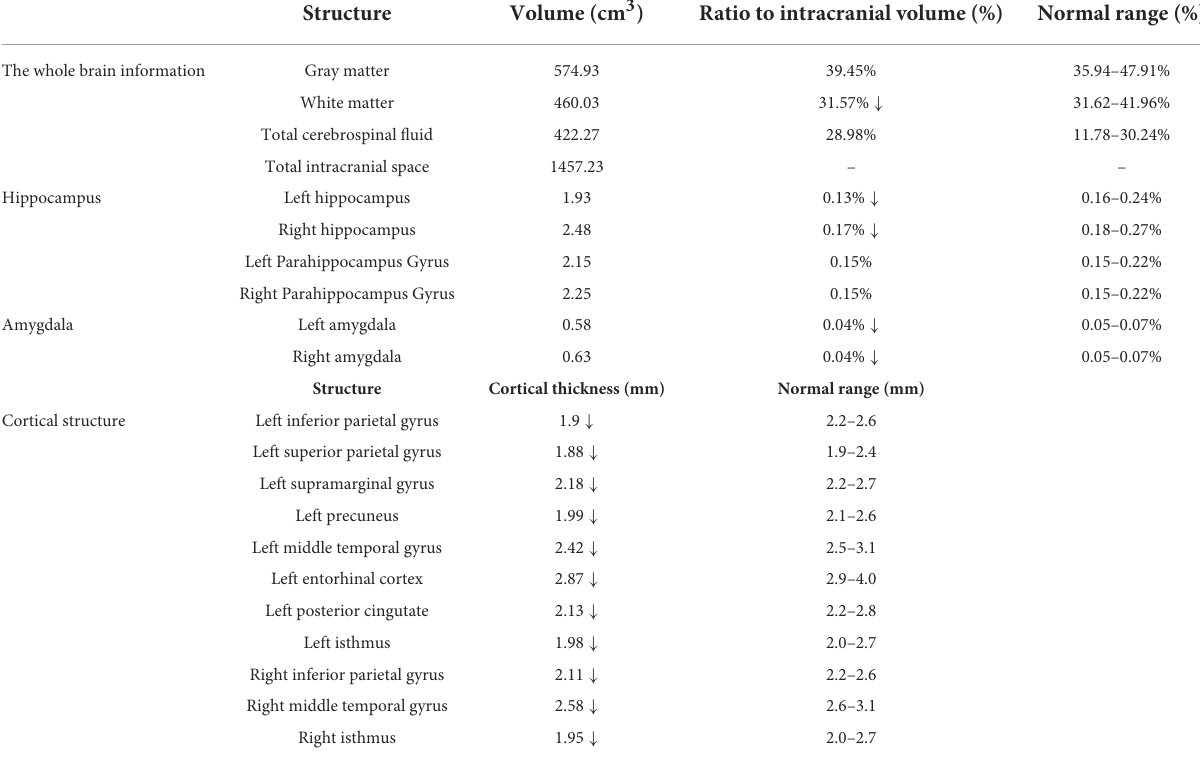
TABLE 2 The structural MRI features based on artificial intelligence